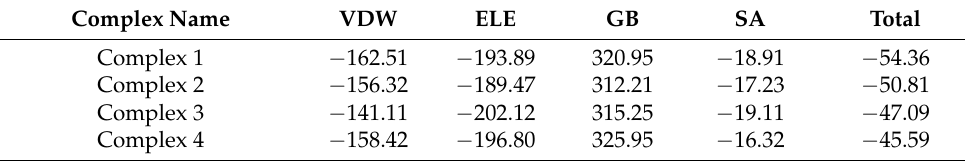
Table 1. Binding free energy calculated as MM/GBSA. All energies are given in kcal/mol. Complex Name VDW ELE GB SA Total Complex